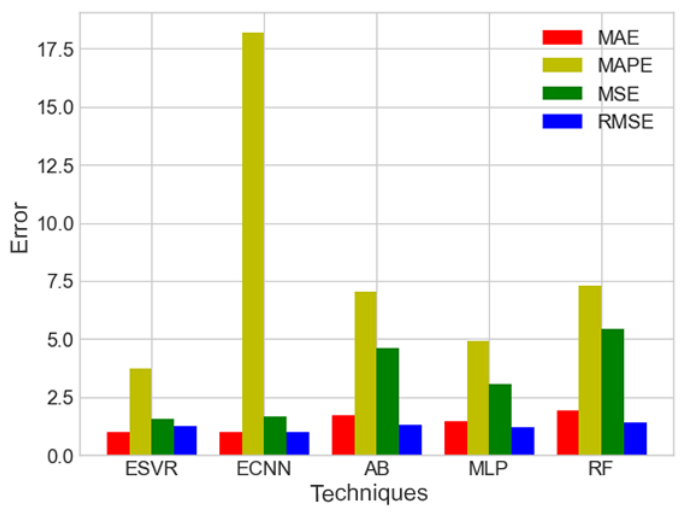
Figure 24. Performance metrics of different